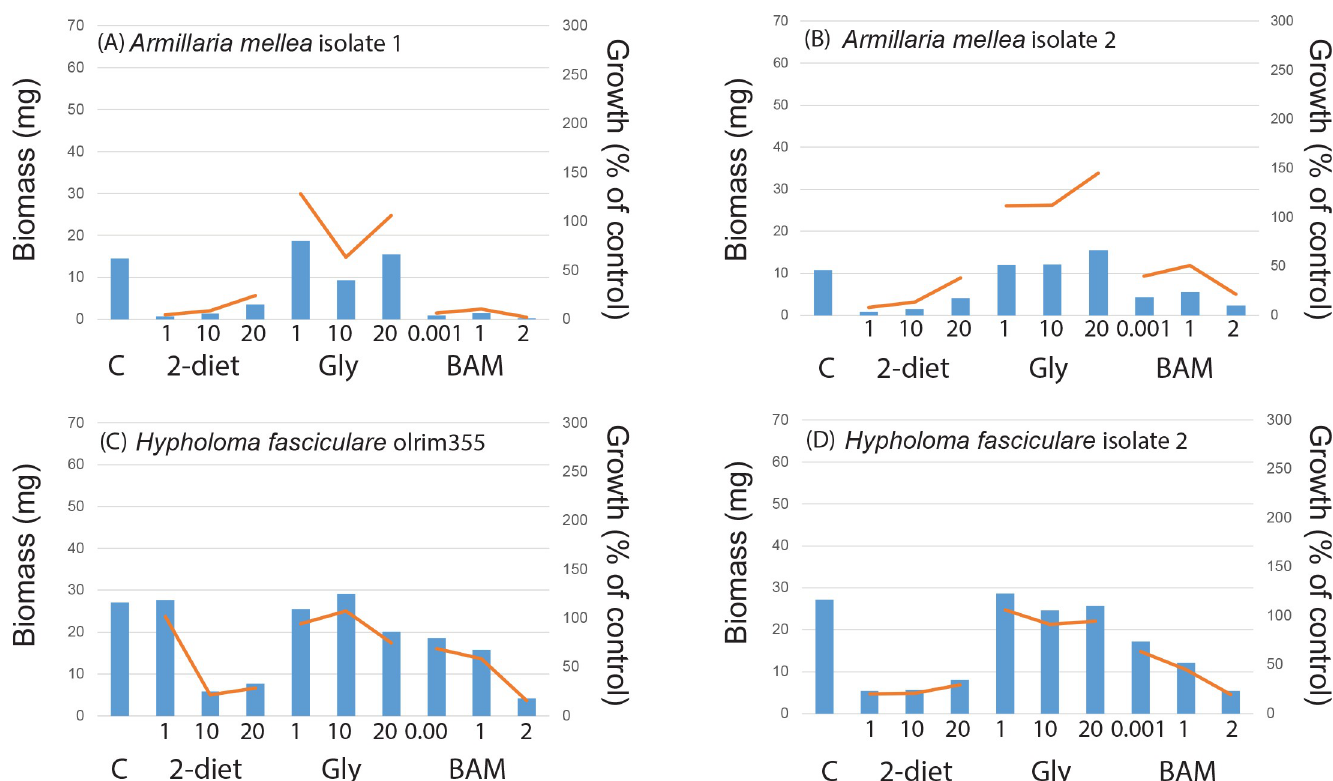
Fig 4. Intra-specific saprotrophic fungal growth responses to recalcitrant amine, amide and ammonium containing media similar among isolates. Intra-specific variation in biomass responses to treatments compared to controls (C, n = 2) for saprotrophic fungal species in a screening experiment including 2-diethylaminoethanol (2-diet), N 3 -Trimethyl(2-oxiranyl)methanaminium chloride (gly) and BAM at three different concentrations (n = 1 for each treatment). For 2-diethylaminoethanol and N 3 -Trimethyl(2-oxiranyl)methanaminium chloride concentrations were 1, 10, and 20 g L -1 , respectively. For BAM 1 μ L, 1 mL, and 2 mL of a saturated solution was added. Bars show biomass (mg), lines show growth as a percentage of the growth controls: (A) and (B) Armillaria mellea , (C) and (D) Hypholoma fasciculare ,